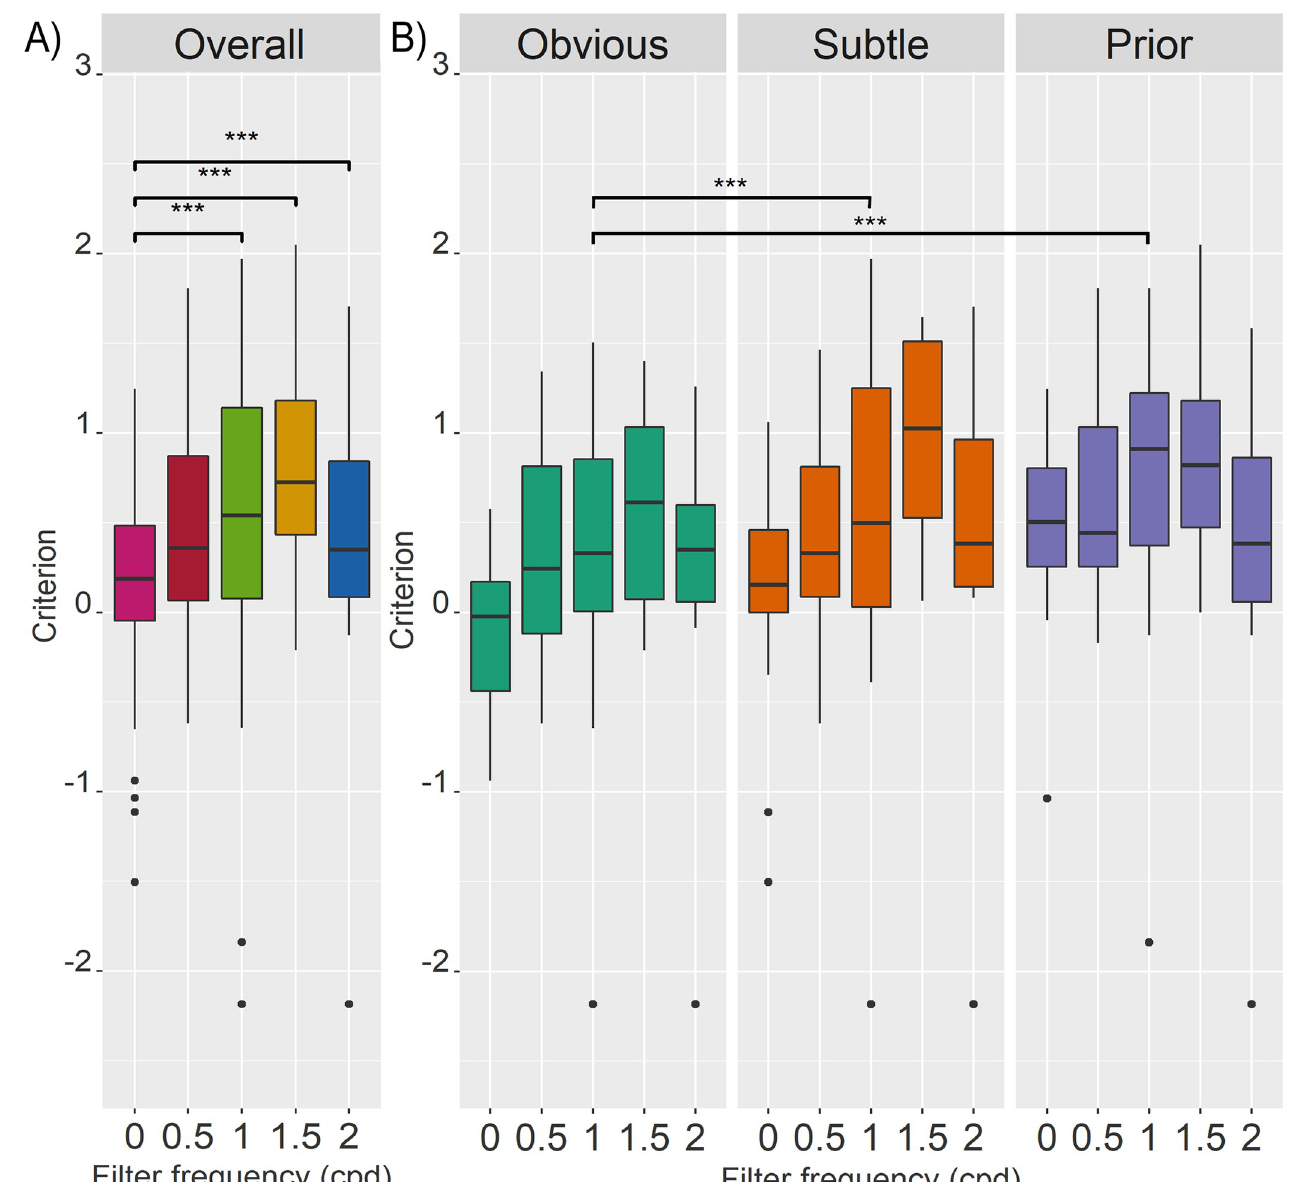
Fig 5. Boxplots of criterion across conditions. Each boxplot shows the median as the line within the coloured box containing the 25 th and 75 th percentiles, with extending whiskers containing the 95% CI, with any outliers plotted as dots. Significance of pairwise comparisons of main effects is indicated in the figure with � = p < .05, �� = p < .01, ��� = p < .001. (A) Criterion across frequency conditions (0, 0.5, 1, 1.5, and 2 cpd). Pairwise comparisons of frequency showed that criterion was significantly higher for F0 than F1 (estimated difference = -0.3295, t(261) = -5.640, p = < .0001), F1.5 (estimated difference = -0.695, t(264) = -9.176, p < .0001), and F2 (estimated difference = -0.480, t(264) = -6.329, p = < .0001), but did not differ significantly from F0.5 (estimated difference = -0.086, t(261) = -1.477, p = .579). (B) Criterion for each mammogram category (obvious, subtle, and prior) and frequency, to illustrate mammogram category and interaction effects. Pairwise comparisons of mammogram category showed that criterion was significantly lower (less conservative) for obvious than subtle (estimated difference = -0.232, t(258) = -4.345, p = < .0001) and prior mammograms (estimated difference = -.347, t(258) = -6.517, p = < .0001), but did not differ significantly between subtle and prior mammograms (estimated difference = -.116, t(258) = -2.172, p =